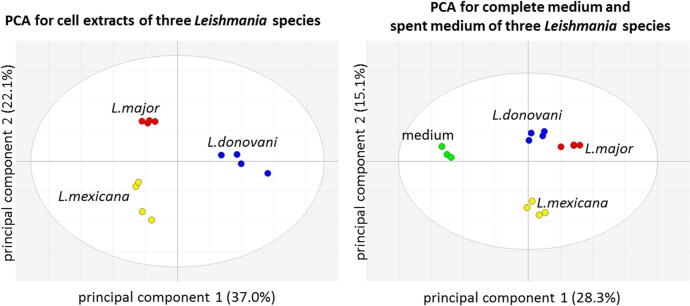
Principal Component Analysis of media and parasite samples.Principal Component Analysis (PCA) for cell extracts of three Leishmania species (left, first two components explain 59.1% of the total variance) and for complete medium and spent media of three Leishmania species (right, first two components explain 43.4% of the total variance). Key: blue, L. donovani; red, L. major; yellow, L. mexicana; green, complete medium. The confidence ellipses are based on Hotelling’s T2 = 95% for both score scatter plots.